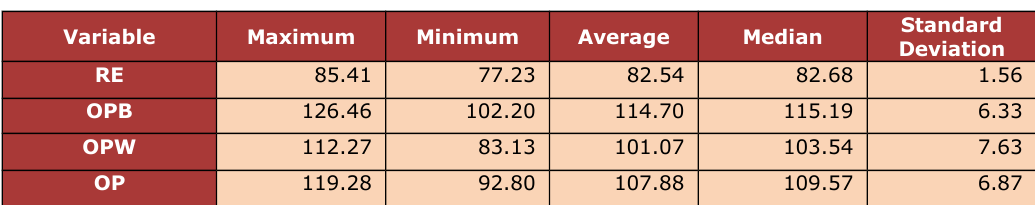
Table 1. Descriptive statistical table of data variables (Data source: Organized and calculated according to statistical software reviews